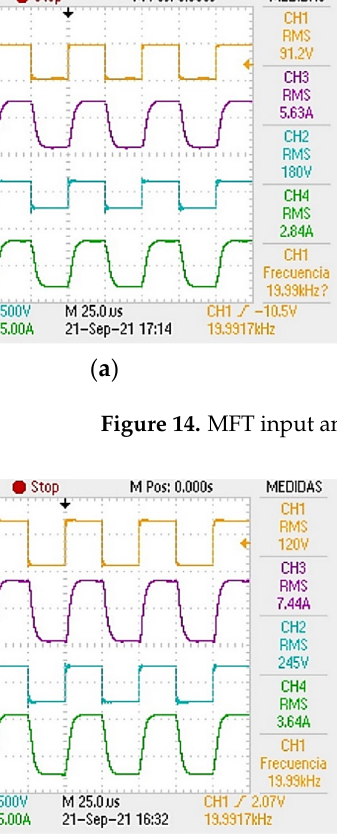
14 of 18 Figure 11. Block diagram of the experimental setup: ( a ) a DC variable source 0–120 V, ( b ) H Bridge (Mosfets), ( c ) DSP, ( d ) a 12V DC source, ( e ) MFT, ( f ) Load, and ( g ) Oscilloscope. The comparison between voltages and currents of both MFTs prototypes at full load (Figure 15) are presented in Table 10, along with the corresponding efficiency values. Ta- ble 11 shows the efficiencies obtained at 6%, 25%, and 50% of the nominal power. Figure 16 shows a thermography of the MFT prototype, taken with a thermal camera (Milwaukee M12TM 7.8 KP). In this case, the maximum temperature was 73.7 °C for ferrite, and 46.4 °C for nanocrystalline alloys. The test was realized at 28 °C room temperature for 1 h. ( a ) ( b ) Figure 12. MFT input and output voltages and currents (6% P nom ): ( a ) Nanocrystalline, ( b ) Ferrite.